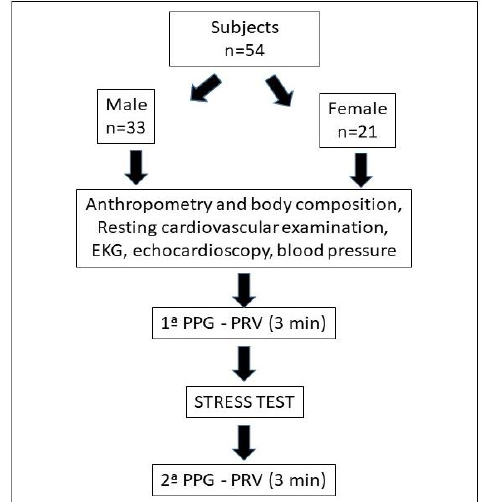
Figure 2. Flowchart of participants and procedures.